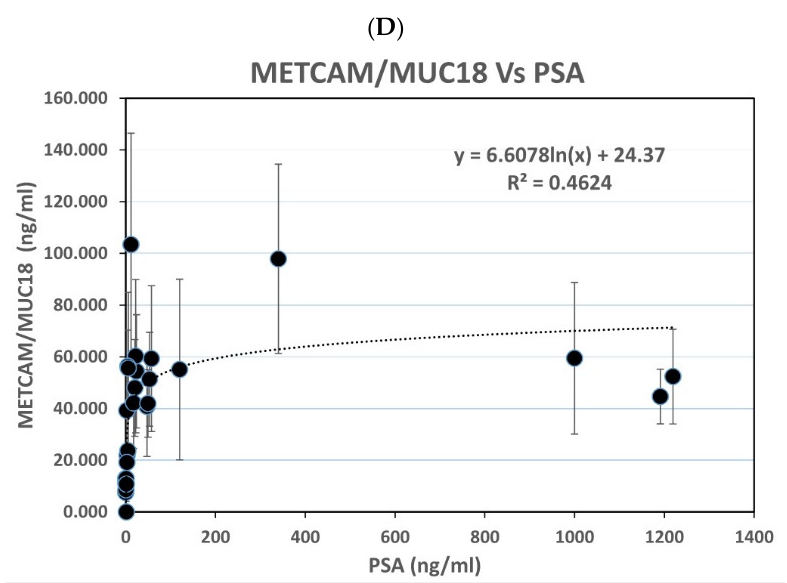
Figure 7. ( A ) METCAM vs. PSA (#1) combo2; ( B ). METCAM vs. PSA (#2) combo2, ( C ). METCAM vs. PSA (#3) comb2, ( D ). METCAM vs. PSA (#4) comb2. Relation of PSA to the huMETCAM/MUC18